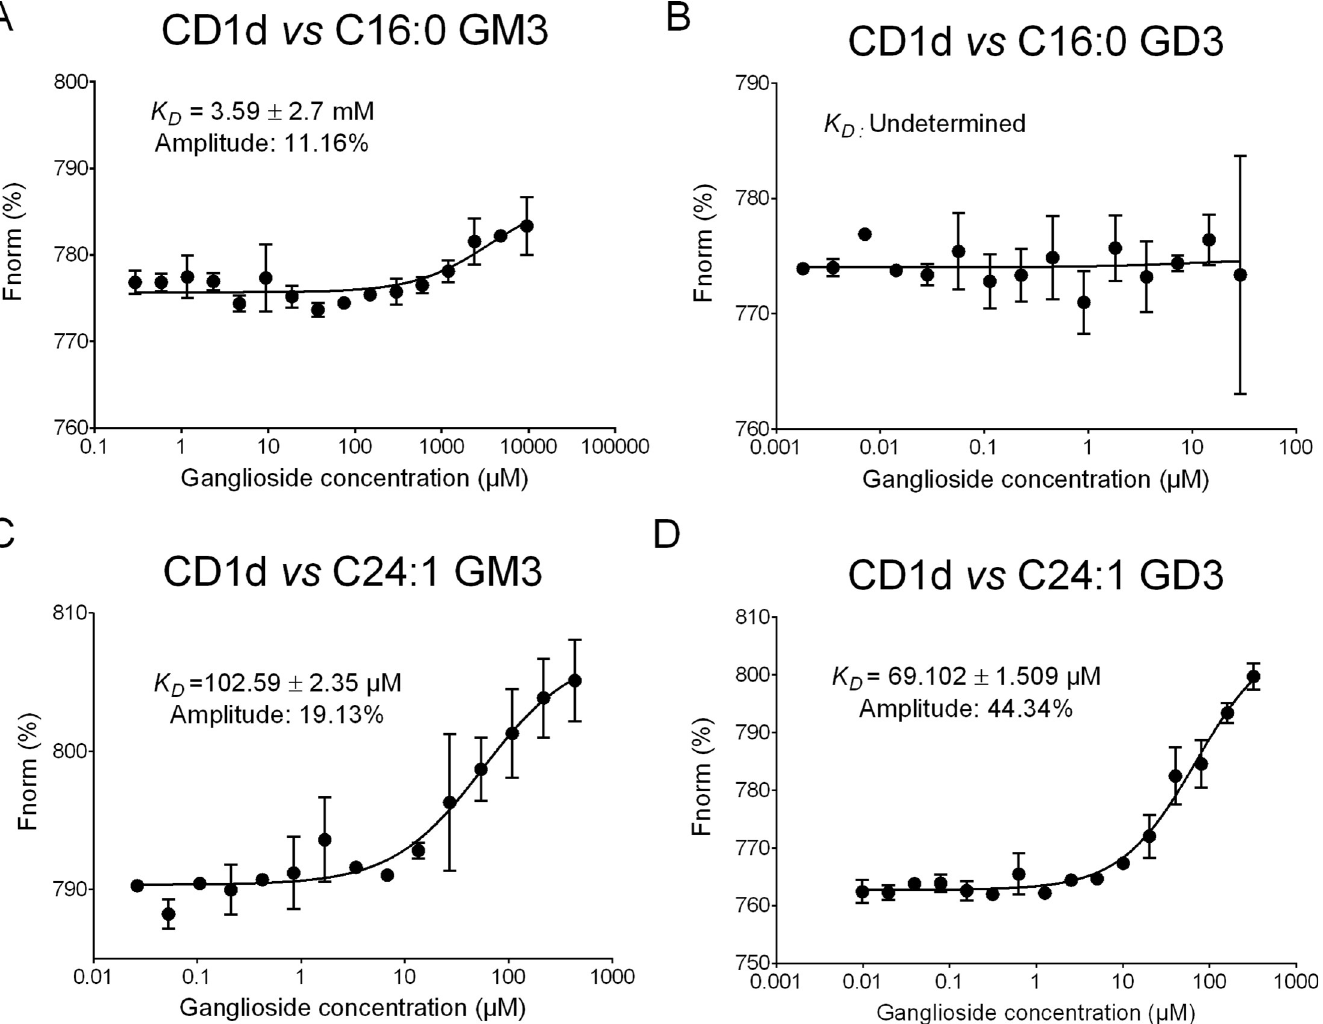
Fig 4. Thermophoretic analysis of NT647-labeled mouse CD1d-ganglioside interaction. Changes in thermophoresis of a titration of 125 nM NT647-labeled mouse CD1d with increasing concentrations of C16:0 GM3 (A), C16:0 GD3 (B), C24:1 GM3 (C), and C24:1 GD3 (D) are expressed as change of the normalized fluorescence ( Δ Fnorm = FHot/Fcold) and plotted. Line is a fit with Michaelis–Menten kinetics of Δ Fnorm mean ± SD for each ligand concentration of three independent measurements. Underlying data used in the generation of this figure can be found in S1 Data.